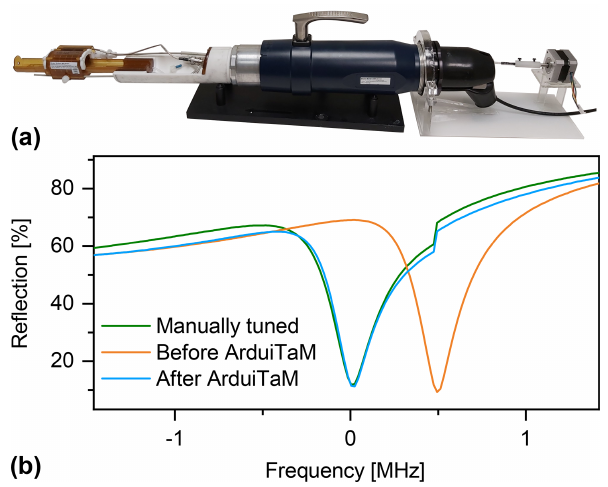
Figure 8. (a) Integrating the ArduiTaM with a commercial MRI probe (Bruker ICON). (b) “Wobble” curves showing the coil’s re- flection when it is manually tuned, and before and after the auto- matic tuning using the